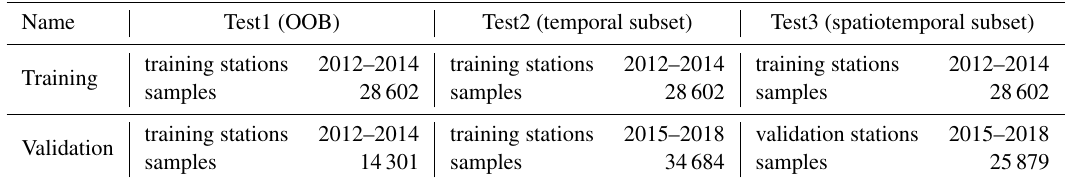
Table 3. Summary of three tests of the fitted RF algorithms in Table